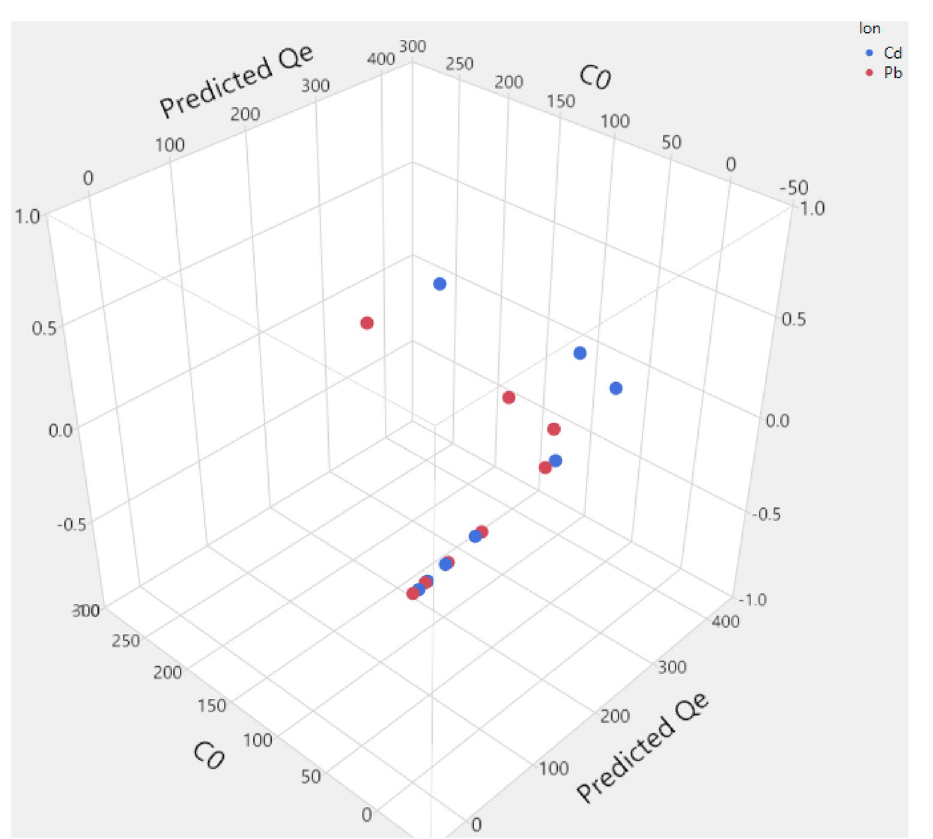
Figure 7. Scatterplot 3D of predicted